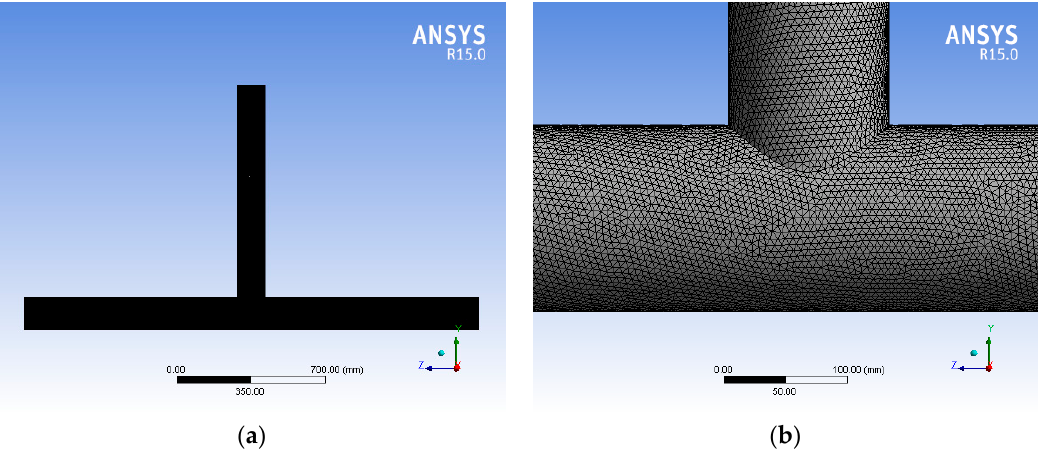
Figure 15. The mashing result; ( a ) Overall view; ( b ) Partial view.